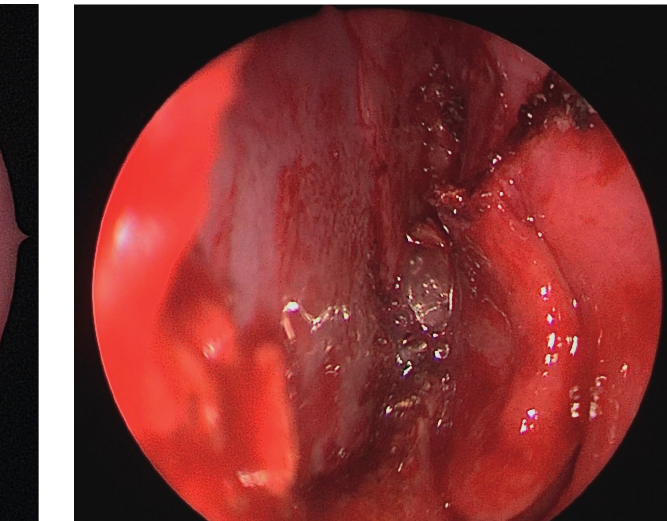
Figure 2. Endoscopic view of the left nasal mass arising from the superior aspect of the nasal cavity.